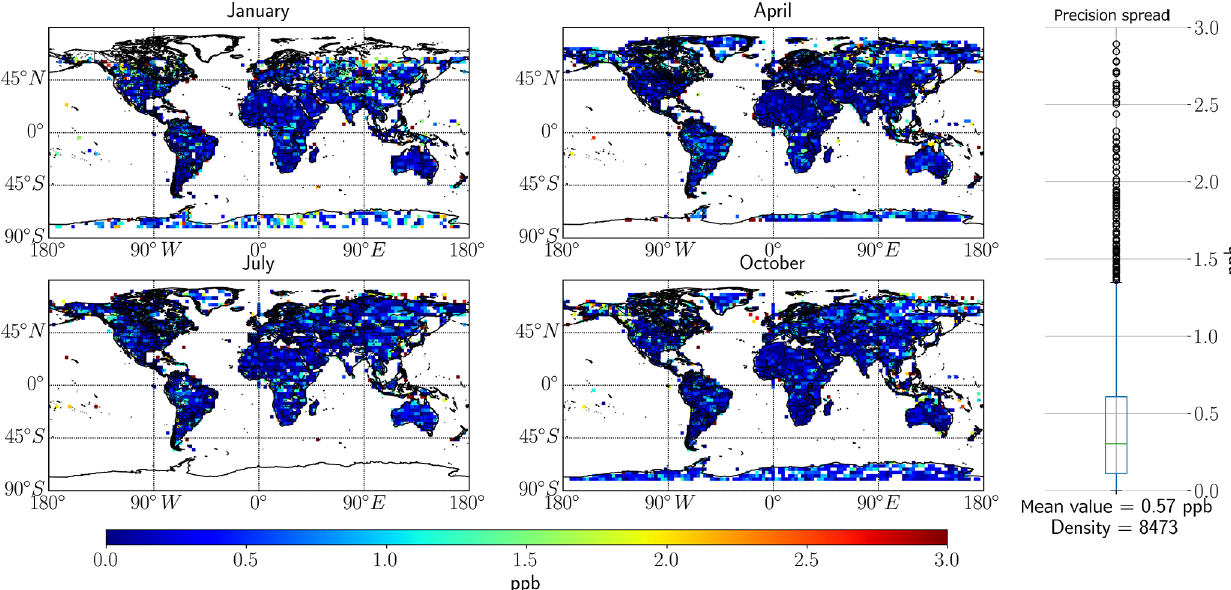
Figure A1. Global spread of precision errors based on the RemoTeC synthetic data ensemble for the SWIR1 band, with 13 CH 4 as the target for retrievals. The four main seasons in the synthetic database are represented in this figure by 1d in the months of January, April, July and October. The far right panel in the figure outlines the spread of error values over the entire dataset, with the mean value and the total number of measurements indicated at the